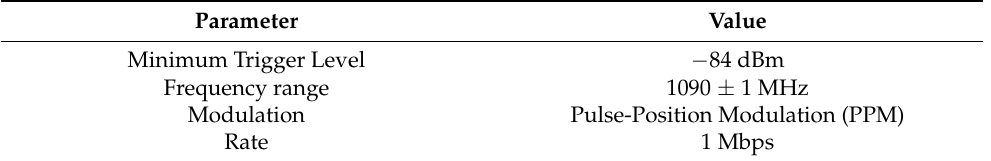
Table 2. ADS-B Class “A3” Device Receiver Specifications.